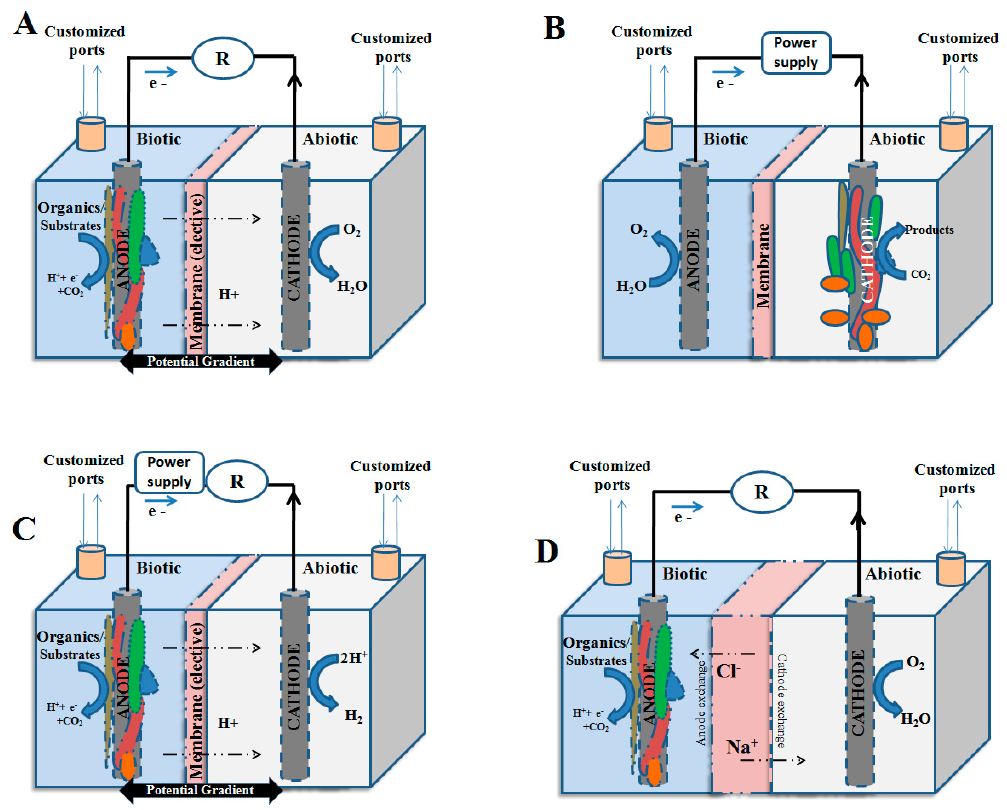
Figure 2. Variants of MES: ( A ) microbial fuel cells (MFC); ( B ) microbial electrolysis cell (MECs); ( C ) microbial electrosynthesis (MES); and ( D ) microbial desalination cells (MDCs).